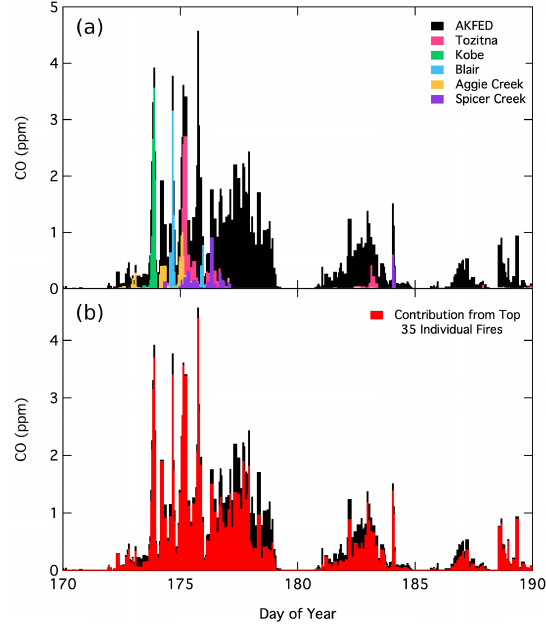
Figure 10. (a) Top five individual fire contributions to the CO anomalies simulated at the CRV tower. The black line shows the original PWRF-STILT × AKFED model, pink denotes contribu- tions from the Tozitna fire, green denotes contributions from the Kobe fire, blue denotes contributions from the Blair fire, gold de- notes contributions from the Aggie Creek fire, and purple denotes contributions from the Spicer Creek fire. (b) The total CO anomaly from the 34 fires that contributed to at least 1% of the modeled CO anomaly at the CRV tower (red) compared to the sum of all fires shown in black derived from the original PWRF-STILT × AKFED simulation